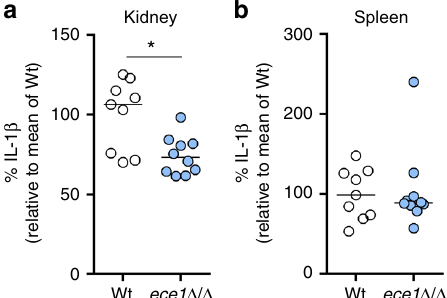
Fig. 1 Kidney and spleen IL-1 β levels during systemic candidemia. a , b IL-1 β levels measured in a kidney and b spleen homogenates that were obtained at 1 day post infection from C57/Bl6 mice infected intravenously with C . albicans Wt or the ece1 Δ / Δ mutant strain. Values are represented as scatterplot and the median of two independent experiments. The mean of the Wt control group was set at 100% to determine the percentage reduction in IL-1 β levels in the mice infected with the ece1 Δ / Δ mutant. The means of experimental groups were compared for statistical signi fi cance using the Mann – Whitney U test. * p ≤